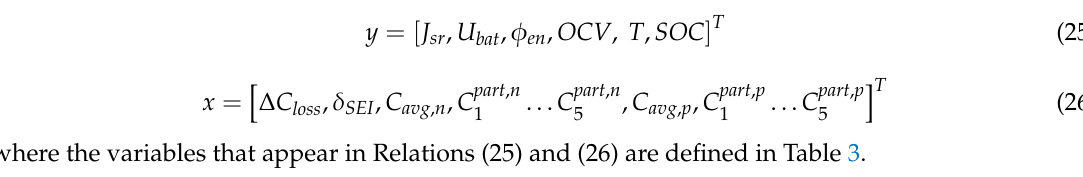
Table 3. Variables in the state and output vectors of the nonlinear cell model * I = p (cathode), n (anode).